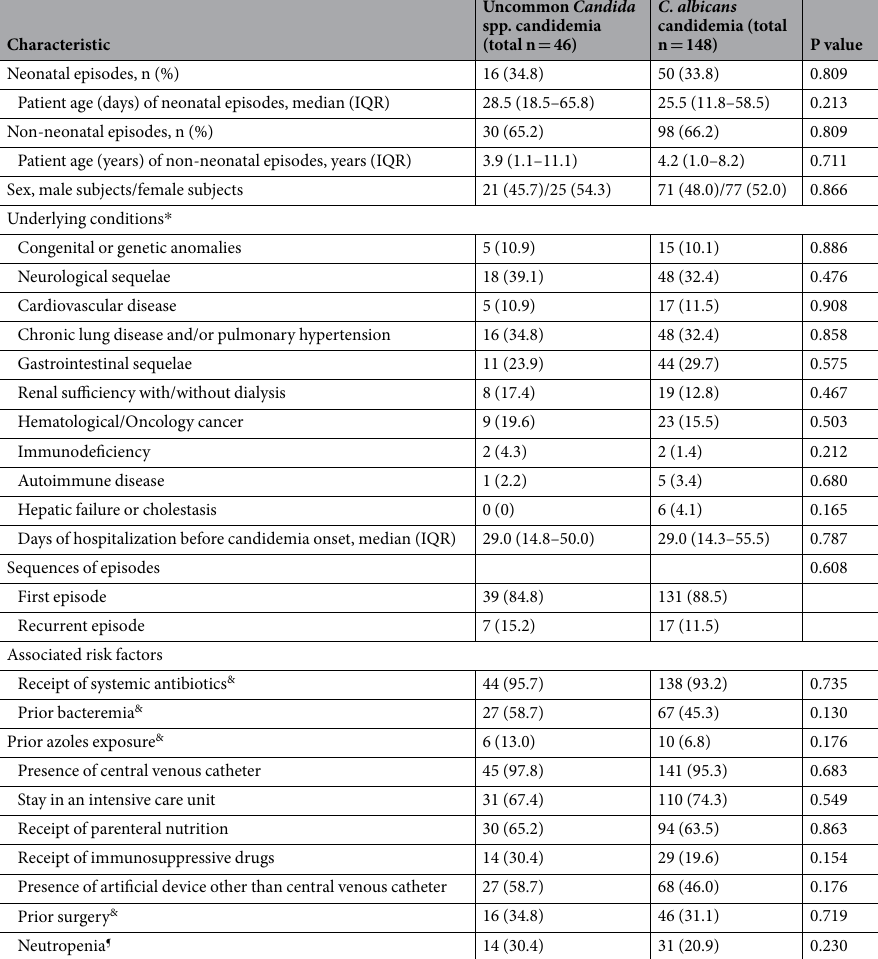
Table 2. Demographic and clinical characteristics of 46 episodes of candidemia caused by uncommon Candida spp. versus 148 episodes of C. albicans candidemia. All data were expressed as number (percentage %), unless indicated otherwise; IQR: interquartile range. * Indicated the presence of underlying condition or risk factor at onset of candidemia, and most patients with candidemia had > 1 underlying condition and/or risk factor. & Within one month prior onset of candidemia, prior azoles exposure indicated patients received azoles drug in addition to the antifungal agents at time of candidemia. ¶ Absolute neutrophil count ≤ 500 cells/ μ